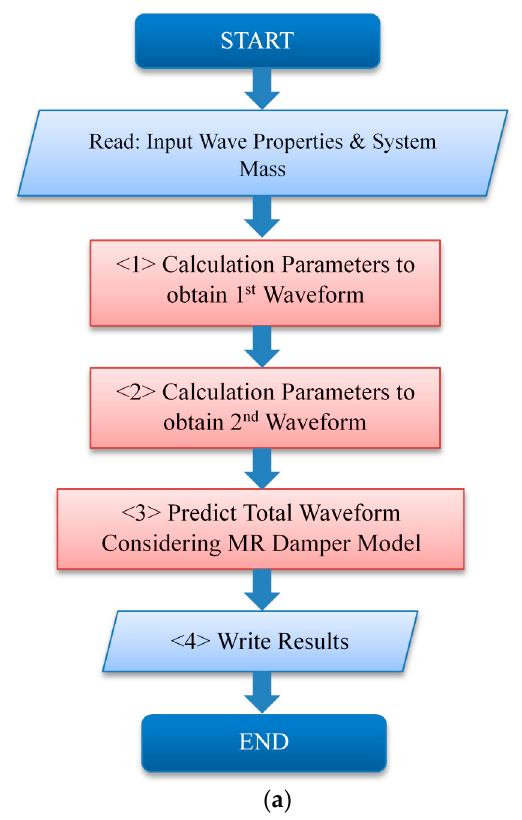
Input waveform properties System mass